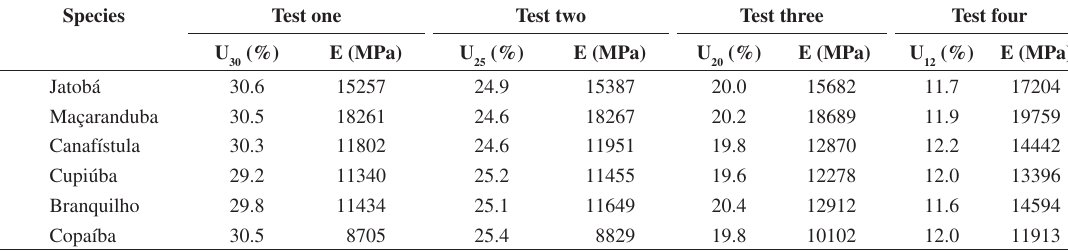
Table 2. Average results of moisture (%) and modulus of elasticity (MPa) per specie chosen. Species Test one